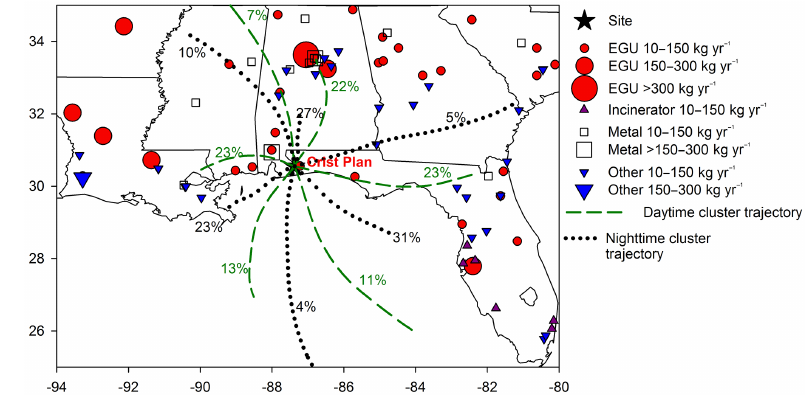
Figure 1. Sampling site and point sources (NEI 2011) map. Cluster trajectories for daytime (11:00–13:00) and nighttime (01:00–03:00). The x and y axes represent longitude and